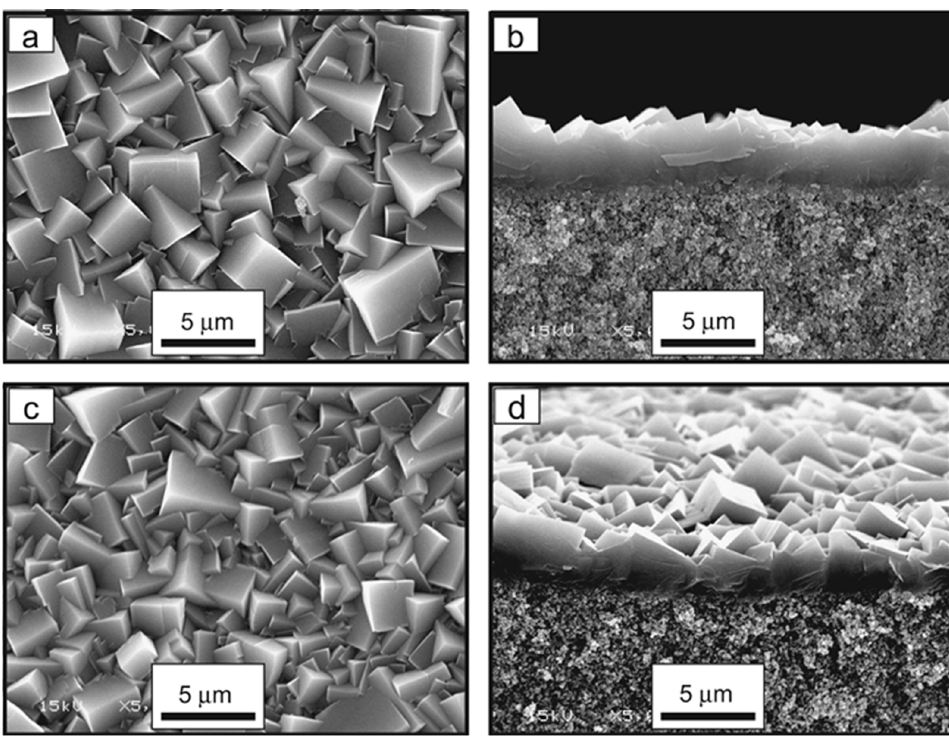
Figure 5. Surface and cross-sectional SEM images of SAPO-34 membranes prepared with Al(OH) 3 and TEAOH/P 2 O 5 ratios of 1.75 ( a , b ) and 2.0 ( c , d ). Adapted with permission from Ref. [99]. Copyright 2013 Elsevier.